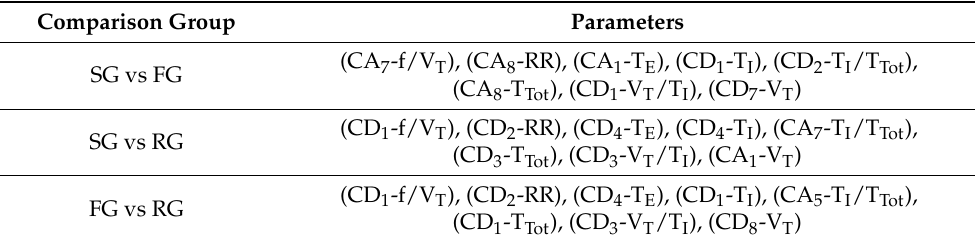
Table 2. Parameters that obtained the maximum value of the Q index when comparing patients of each of the